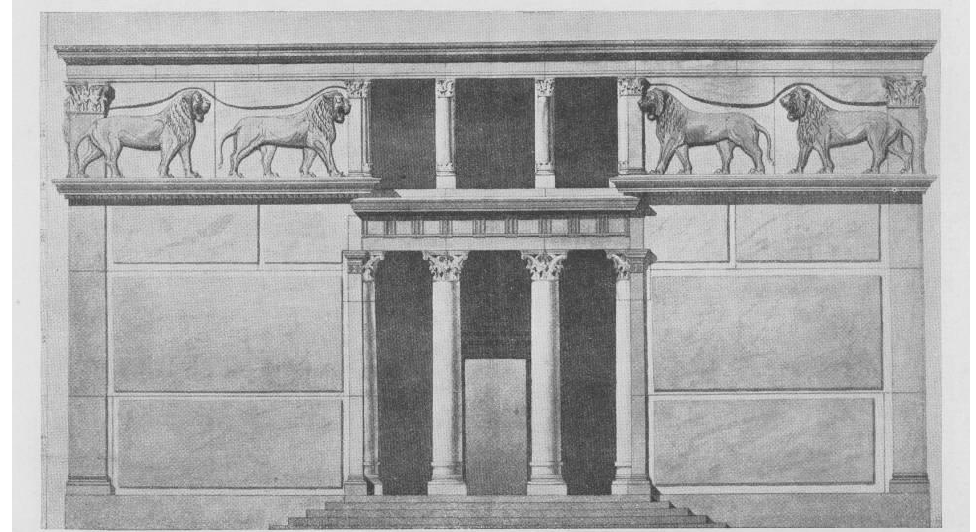
Figure 3. Palace in Araq al-Emir, Jordan, detailed reconstruction by Howard C. Butler, based on the reconstruction by Melchior de Vogüé (1864a). Reproduced from (Cohn-Wiener 1929, p. 70).